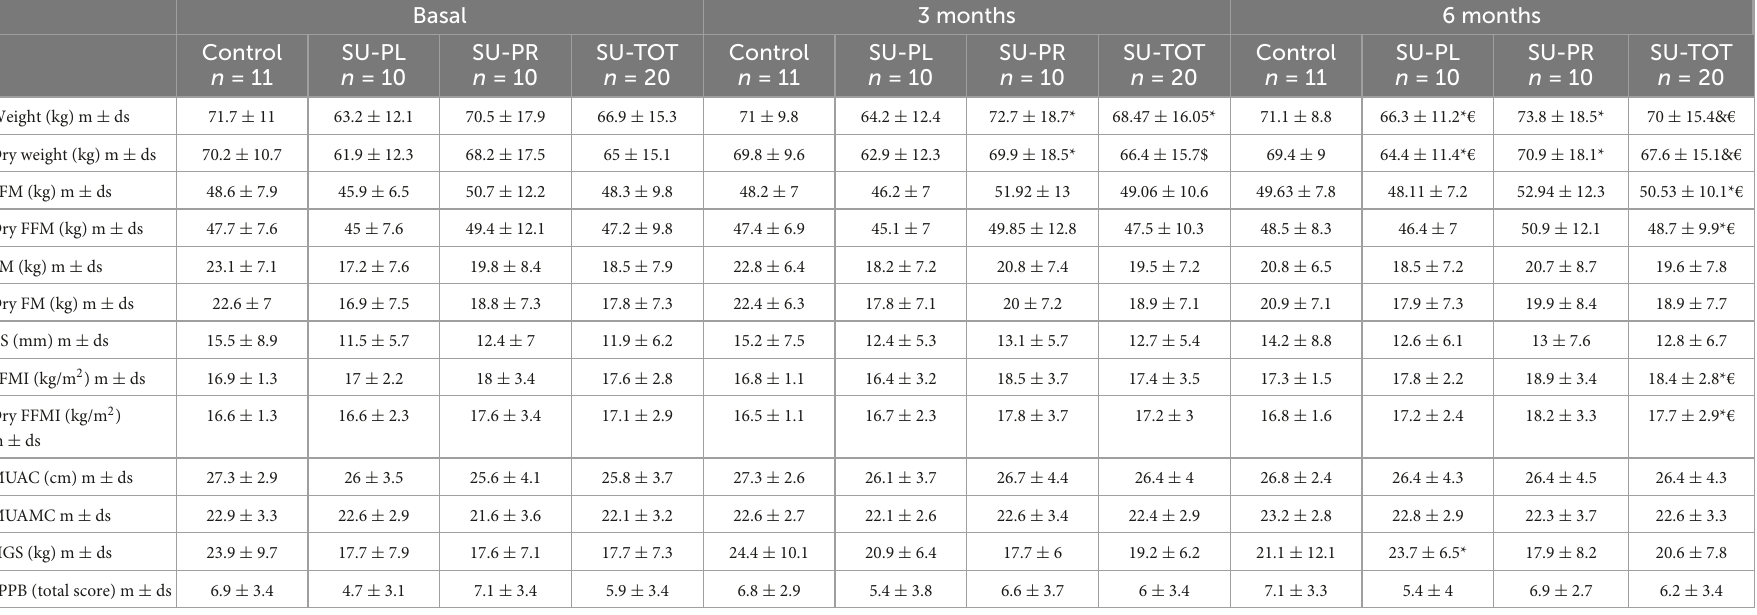
Data are presented as mean ± standard deviation (m ± ds) or median and interquartile range: med (p25; p75); SU-PL, supplement group + placebo; SU-PR, supplement group + probiotics; SU-TOT, supplement group (SU-PL + SU-PR). Differences between baseline and 3- or 6-months intragroup: * p < 0.05; $ p < 0.01; & p < 0.001; differences between 3 and 6 months: € p < 0.05. FFM, fat-free mass; FM, fat mass; TS, triceps skinfold; FFMI, fat-free mass index; MUAC, mid-upper arm circumference; MUAMC, mid-upper arm muscle